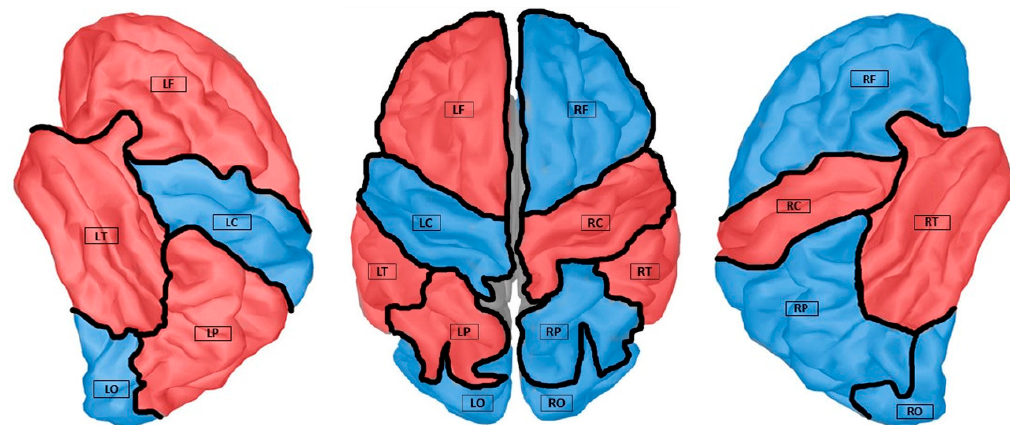
Figure 1. ROI partitions are generated using Brainstorm [21], modified from the standard Desikan–Killiany atlas parcellation and region labels description [22]. The three views show the ROI partitions of the cortical surface and the COH connectivity: red regions indicate the hyper-connection group while the blue regions indicate the hypo-connection group for MCI with respect to HC.